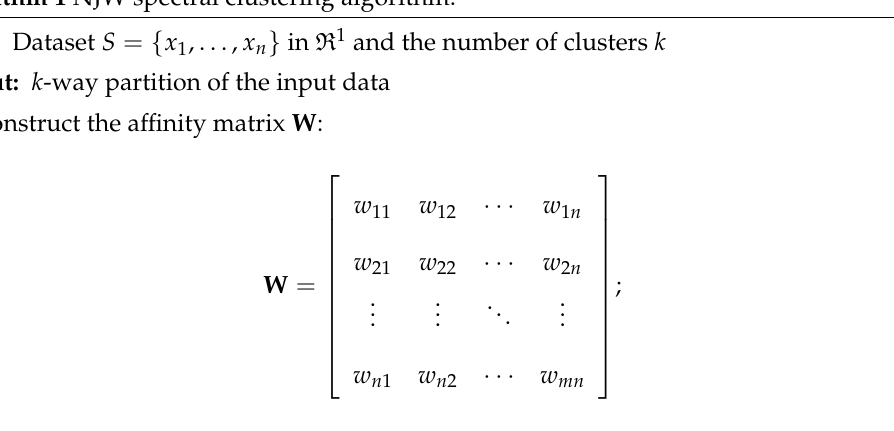
Algorithm 1 NJW spectral clustering